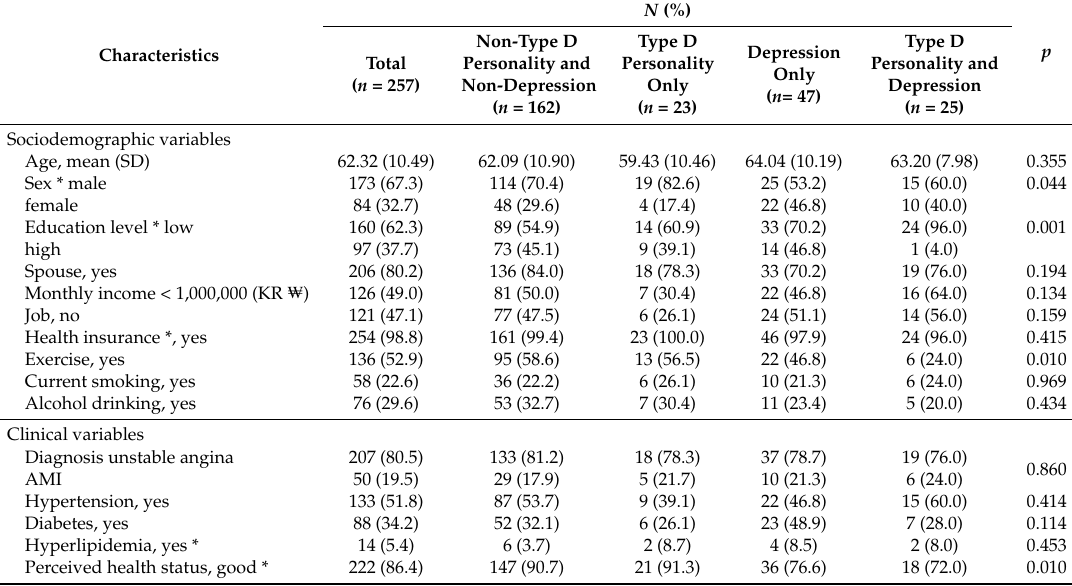
Table 1. Baseline characteristics by Type D personality and depression groups.